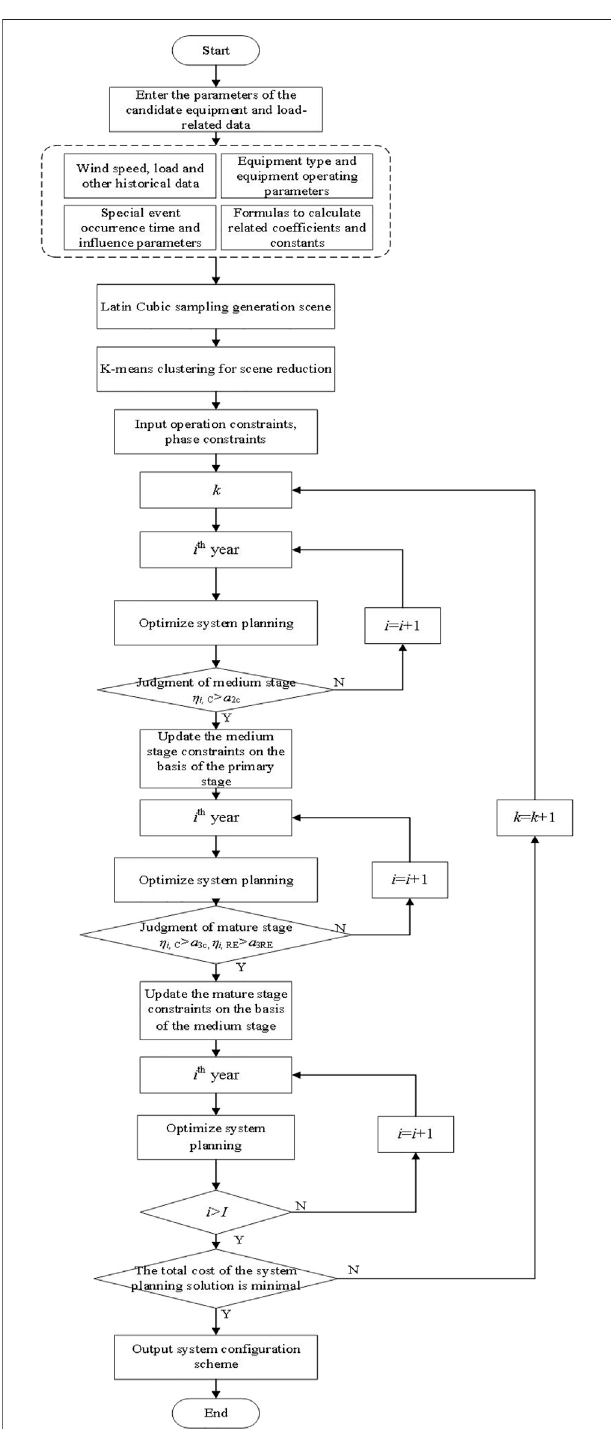
FIGURE 3 | Solution fl